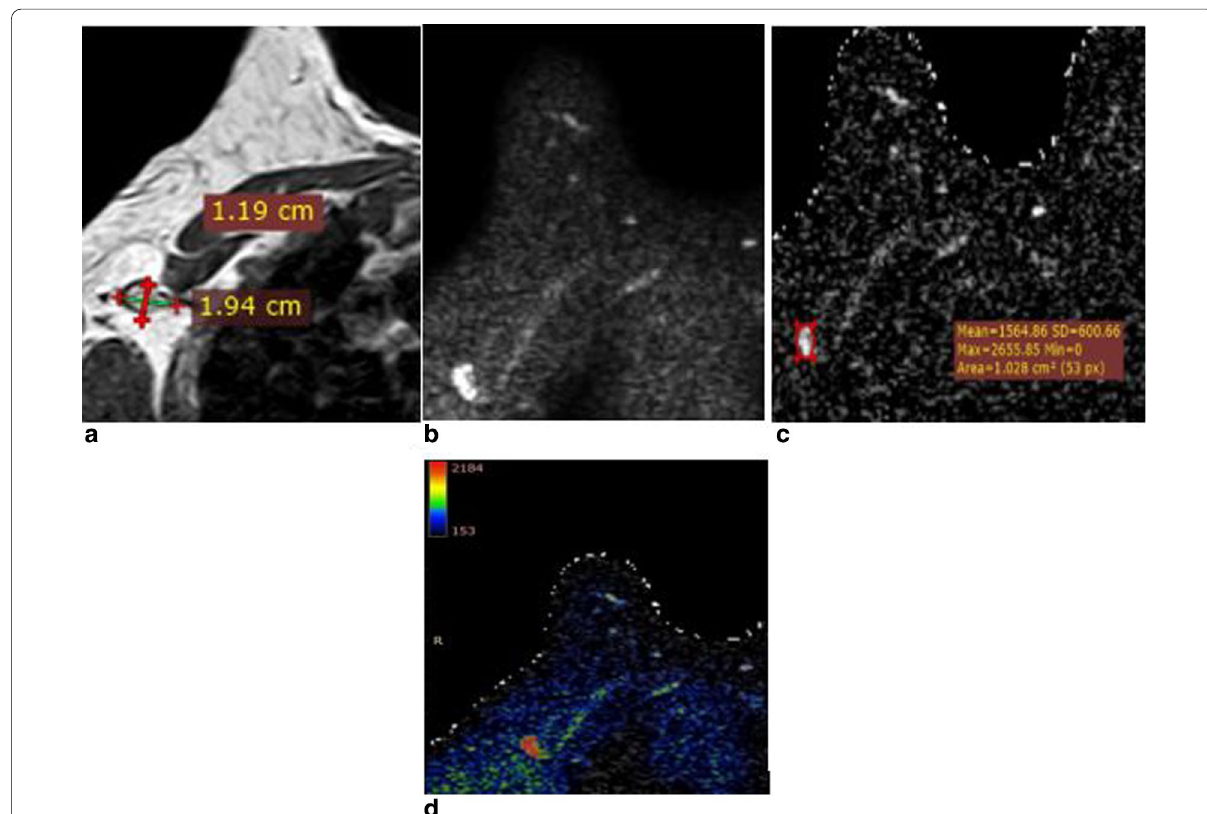
Fig. 6 A 48-year - old female a T1WI enlarged right axillary lymph node with preserved hilum measuring (1.94 map revealed increased SI in both DWI and ADC map with ADC value (1.564 examined lymph node matching with benign texture proved to be benign in histopathological